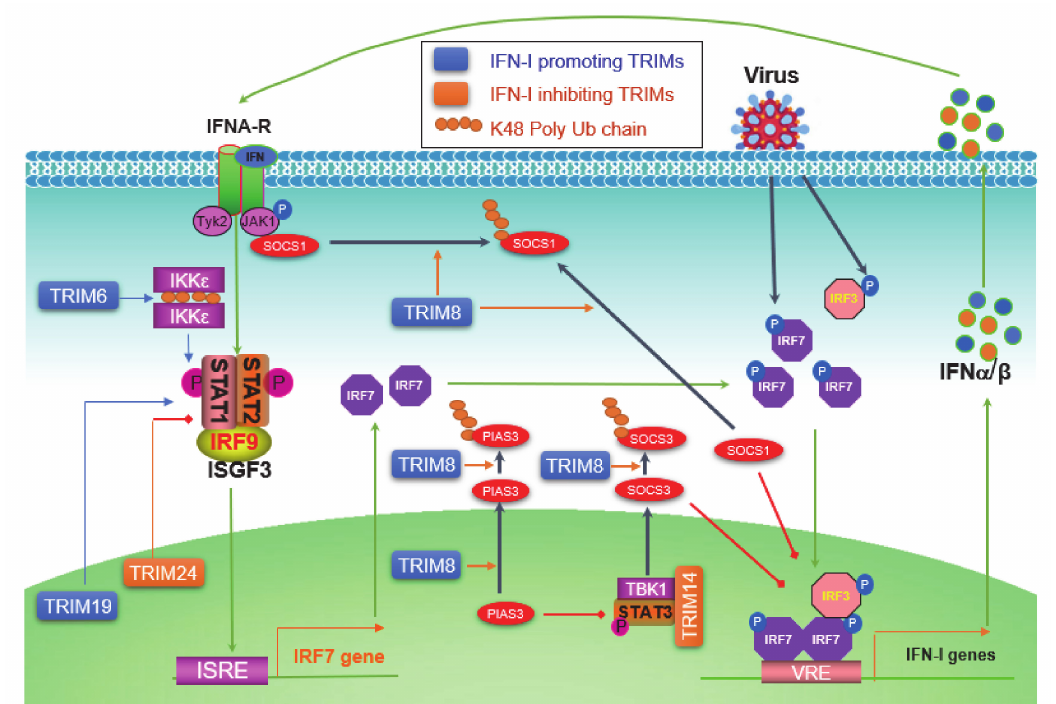
Figure 4. TRIM regulation of the Jak-STAT IFN-I signaling circuit. pathogen-associated molecular patterns (PAMPs) from pathogens activate PRR pathways, leading to the phosphorylation of constitutive high level of IRF3 and low level of IRF7, which induce a low level of IFN-Is. IFN-Is secrete from the cell and bind to IFN-I receptors (IFNAR1 and -2) on the cell membrane, followed by the recruitment and activation of Jak1 and Tyk2, leading to the phosphorylation and activation of STAT1 and -2. Phosphorylated STAT1 and -2 bind to IRF9 to form the ISGF3 (IFN-stimulated gene factor) complex, which functions as the transcriptional activator of more than 300 IFN-inducible genes (ISGs), including IRF7 itself. The induced IRF7 proteins then return to be activated by PRR pathways, and therefore constitute a positive regulatory circuit between IRF7 and IFN-Is, ensuring a potent production of IFN-Is to fight the invading pathogen. TRIM6 promotes free K48-linked Ub chains that serve as a platform to facilitate IKK ε dimerization and activation. TRIM8 regulates the Jak-STAT IFN-I signaling at multiple points. The nuclear TRIM19 potentiates the transcription and activation of STAT1 and -2, and nuclear TRIM24 inhibits RAR α -mediated STAT1 promoter activation. ISRE: Interferon-stimulated response element; VRE: Virus-responsive